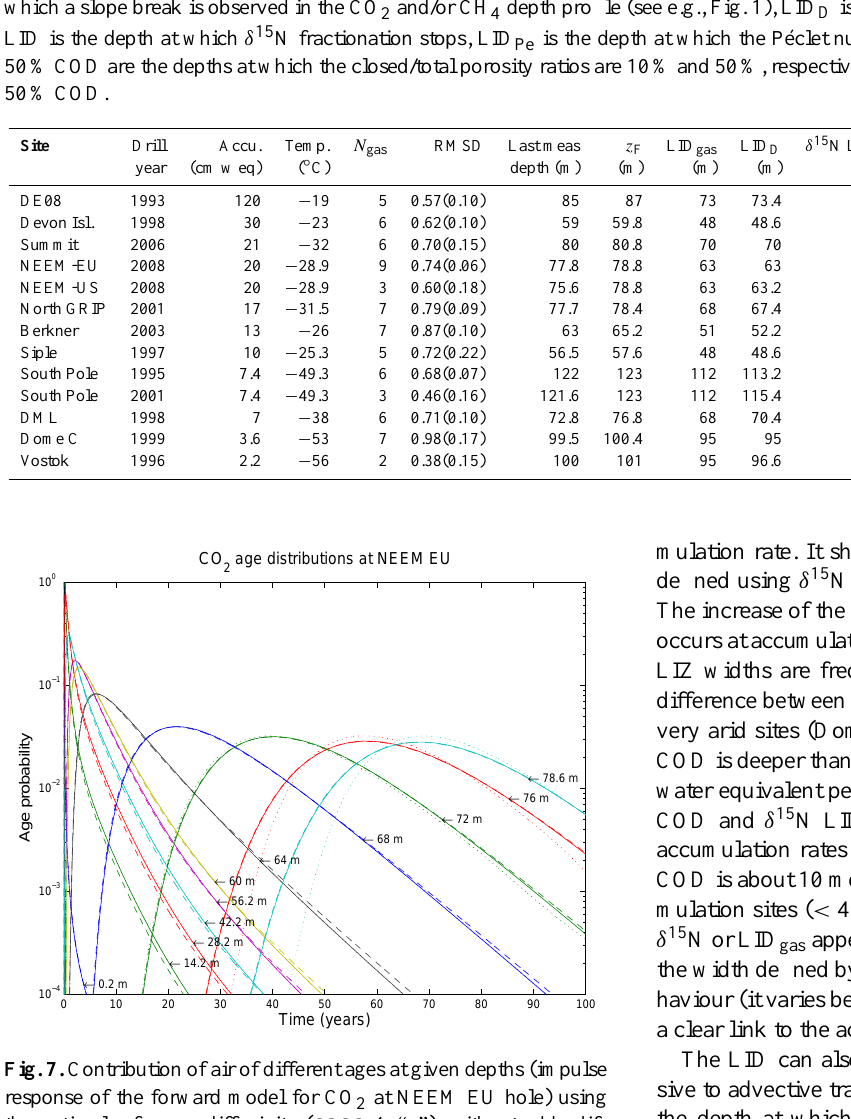
≤ 1m 2 yr − 1 , δ 15 N 2